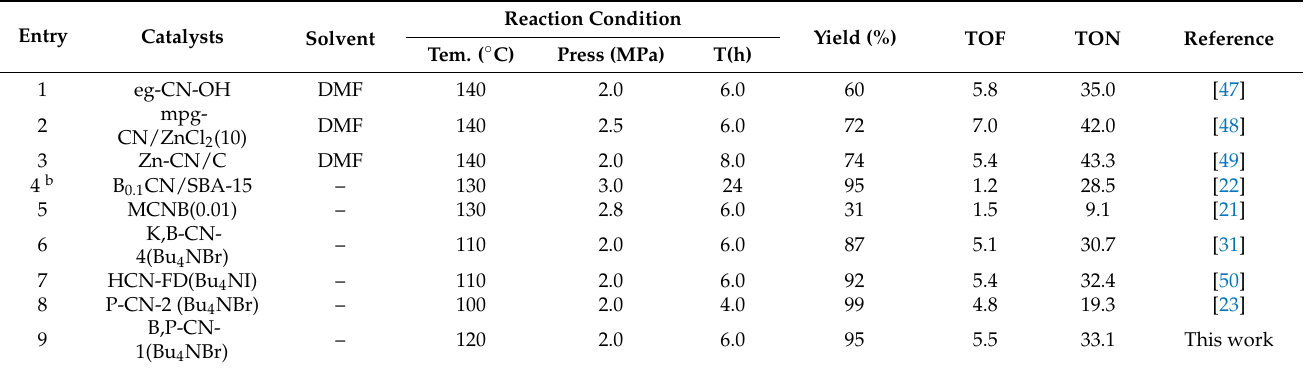
Table 4. Comparisons of B, P-CN-1 catalyst with reported CN catalysts in the CO 2 cycloaddition with epoxides a